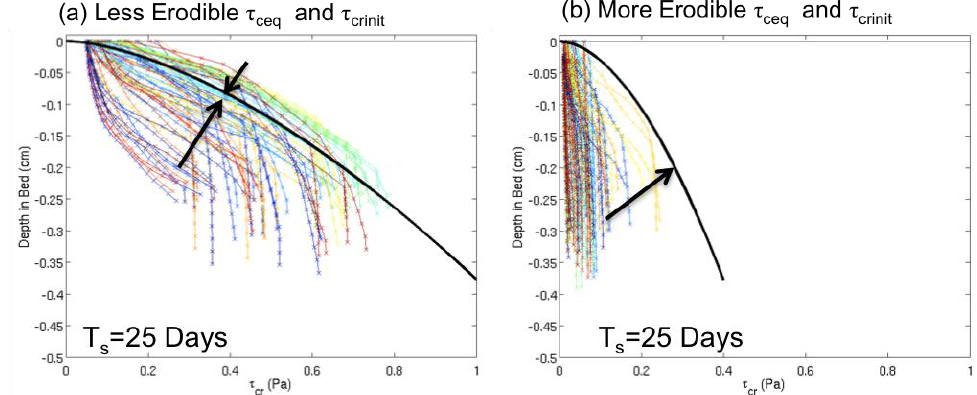
Figure 10. Daily instantaneous model calculated τ profiles (colored lines) shown with the c profile used to parameterize these models (black lines). The equilibrium profile ( τ initial bed profile ( τ ) were defined based on ( a ) September and ( b ) April profiles. crinit Note: τ = τ for these model runs. The black arrows show the direction that Equation (2) ceq crinit will nudge the instantaneous τ toward the user-defined τ c ceq